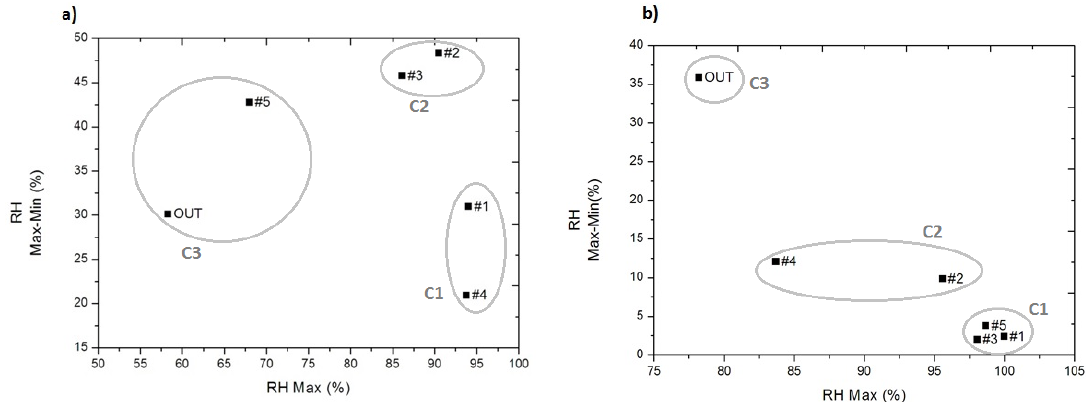
Figure 4. Bivariate plots of mean daily maximum of RH (RH Max) versus mean daily variation of RH (RH Max-Min). ( a ) From 25 July 2013 to 12 August 2013, from 00.00 to 23.59 h (864 data points/sensor); ( b ) from 13 August 2013 to 8 October 2013, from 00.00 to 23.59 h (2,688 data points/sensor).